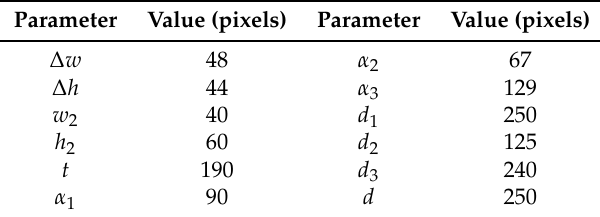
Table 2. Setting for hyper-parameters of